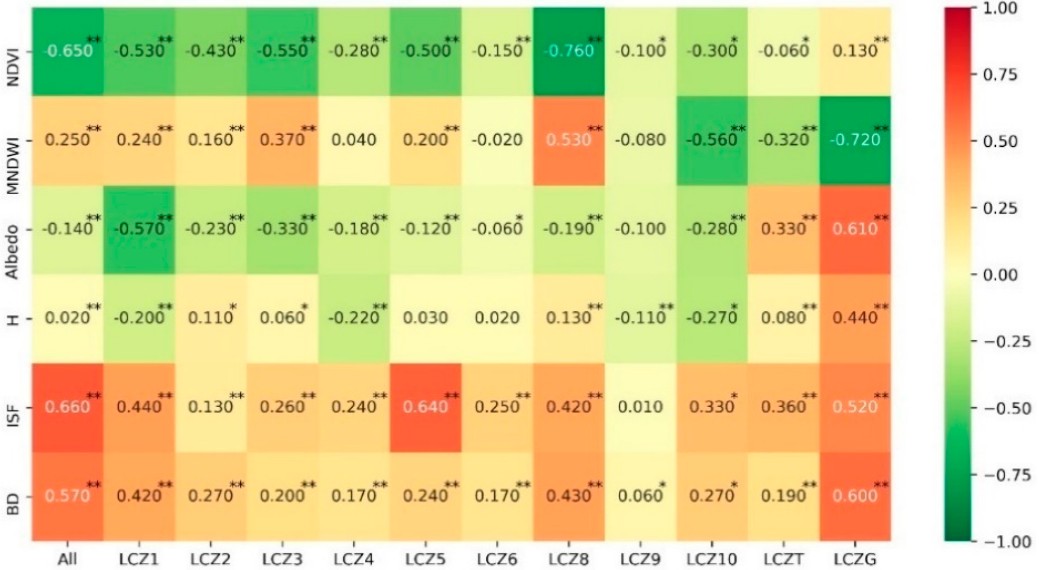
Figure 9. Pearson correlation coefficients between the urban morphology indices and SUHI D. ( **The significance level is 0.01, * the significance level is 0.05).